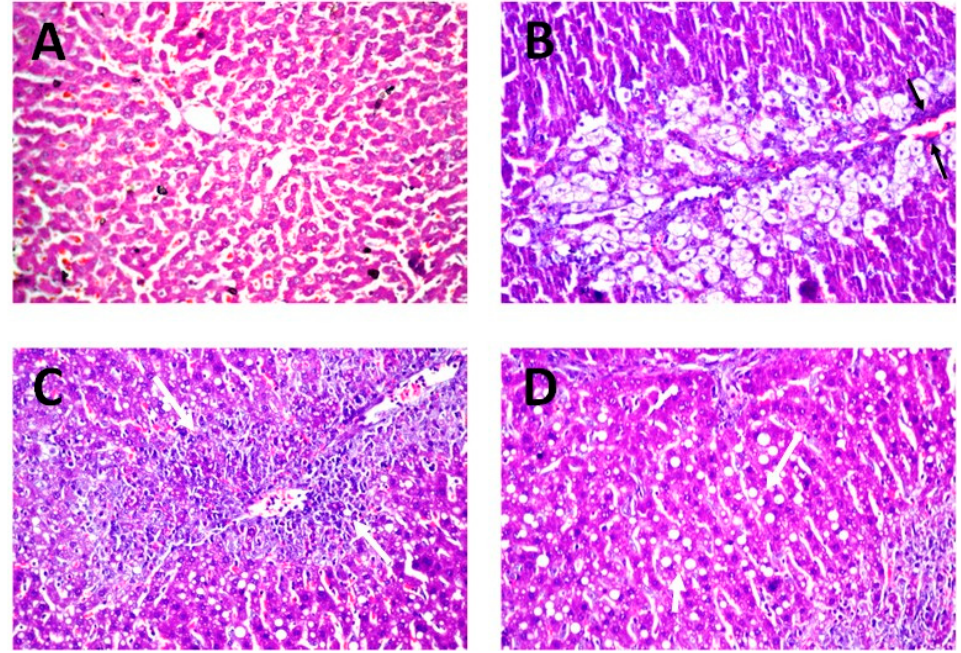
Figure 8. Histology of liver tissue autopsy of rats, using microscope magnification 40×, after administration of ( A ) normal saline (negative control), ( B ) CCl 4 (positive control) and ( C , D ) quercetin niosomes.